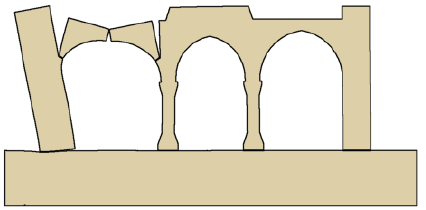
Figure 16. The hypothesized mechanism of collapse for the Ayyubbid Hall, with the 5 hinges typical of vaulted structures.